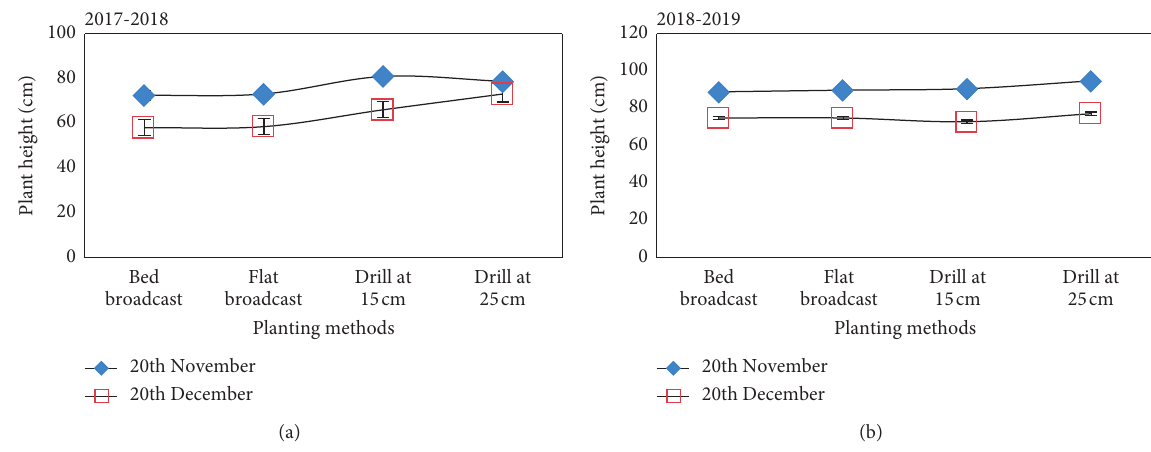
Figure 2: Plant height as affected by planting dates and planting methods during 2017-2018 and 2018-2019